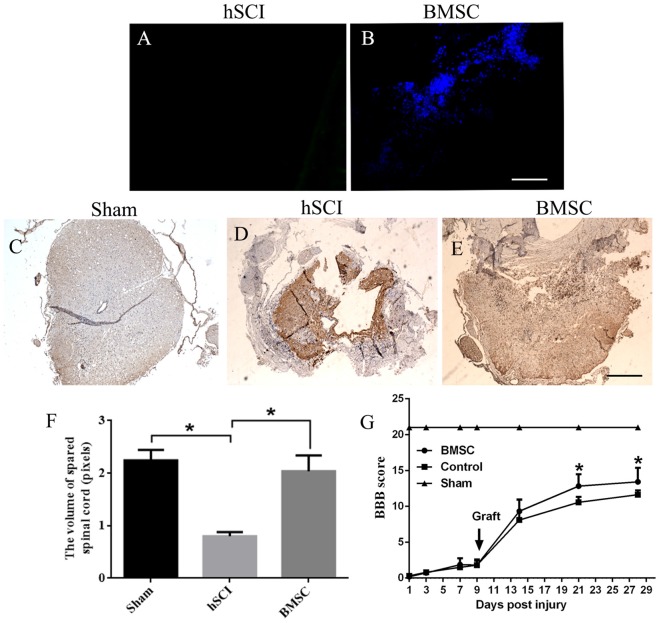
BMSC transplantation restored the volume of spared spinal cord and improved the Hind limb motor function of tree shrews after Hemi-sectioned spinal cord injury (hSCI). (A) Control group showed no positive staining. (B) BMSCs with Hoechst blue staining were widely diffused in the injured tissues at 28 days after injury. (C) Structure of the spinal cord in the sham tree shrews. (D) Structure of the spinal cord in the hSCI tree shrews. (E) Comparatively, BMSCs transplantation resulted in a significant increase on the volume of spared spinal cord. The pictures were taken at 1 cm below the lesion. Bar = 100 μm. (F) The bar chart for quantitative analysis of the volume of spared spinal cord among the sham, hSCI, and BMSC groups using Image-Pro plus 6.0 software. *p < 0.05 compared with the control. Data are presented as the mean ± SD (n = 5, one-way ANOVA). (G) Basso, Beattie, and Bresnehan (BBB) scores among the sham, control and BMSC groups at day 1–28 after injury. *p < 0.05 compared with the control. Data are presented as the mean ± SD (n = 10, one-way ANOVA). Arrowheads indicate the BMSC transplantation time. Control is the hSCI control group. BMSC group is hSCI + BMSCs group.